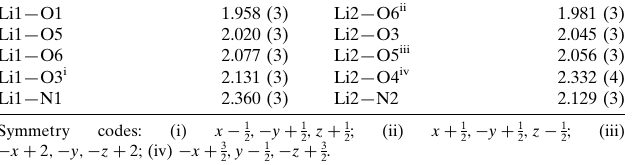
Selected bond lengths (A˚ ).